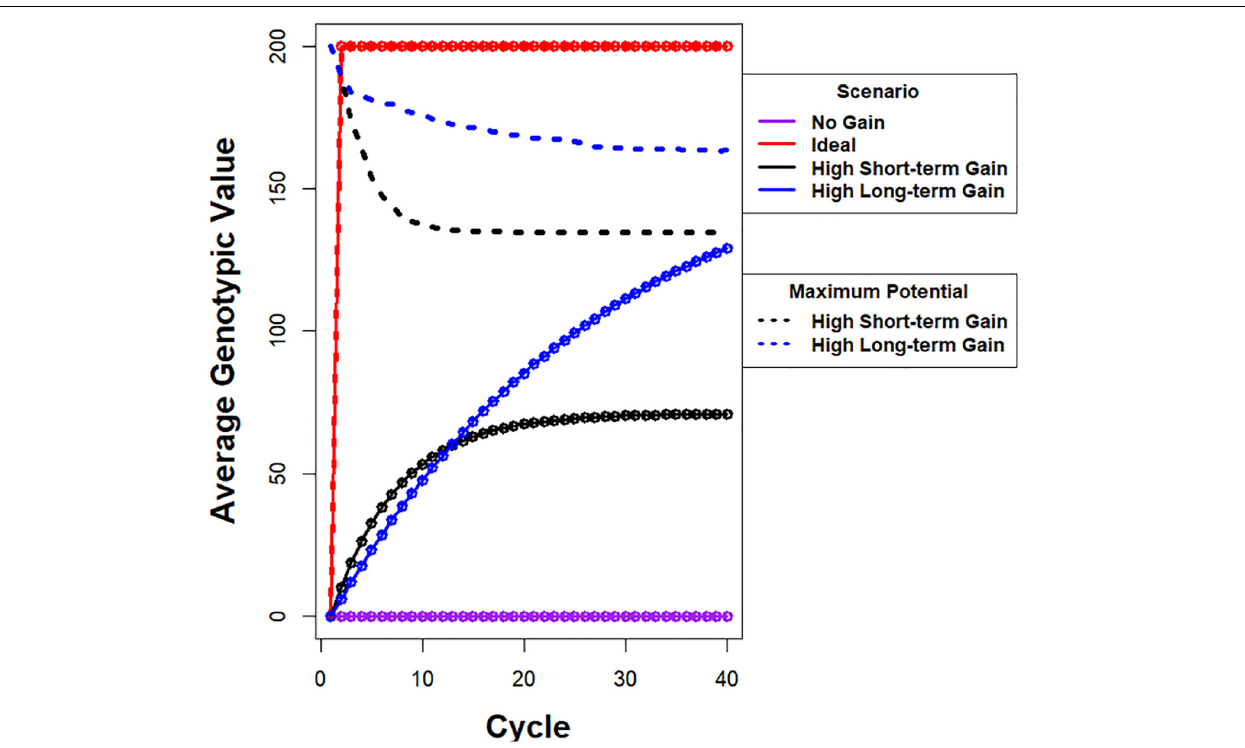
FIGURE 1 | Illustration of possible responses to recurrent selection. Average genotypic value is plotted on y -axis and cycle number is plotted on x -axis. (i) The purple line depicts a response pattern with no genetic gain, which is possible when there is no selection in a population with a large effective population. (ii) The red line depicts a hypothetical ideal response curve when the maximum genotypic potential among founders is realized in one cycle of selection. The ideal is not feasible using selection if the alleles responsible for the maximum are distributed among more than two founders. (iii) The black line depicts a response pattern with high rates of gain in the early cycles, but the maximum average genotypic value approaches a limit that is less than 40% of the genotypic potential among the founders. The dashed black line represents the corresponding rapid drop in genotypic potential among the founders. (iv) The blue line depicts a response pattern with slightly slower rates of gain in early cycles relative to the black line, but achieves greater genotypic values before approaching a limit. This is due to conservation of genetic variability as represented by the dashed blue line with slower rate of decrease in genotypic potential of the population. Note that there are potentially an infinite number of unique response curves that fall between no response and an ideal